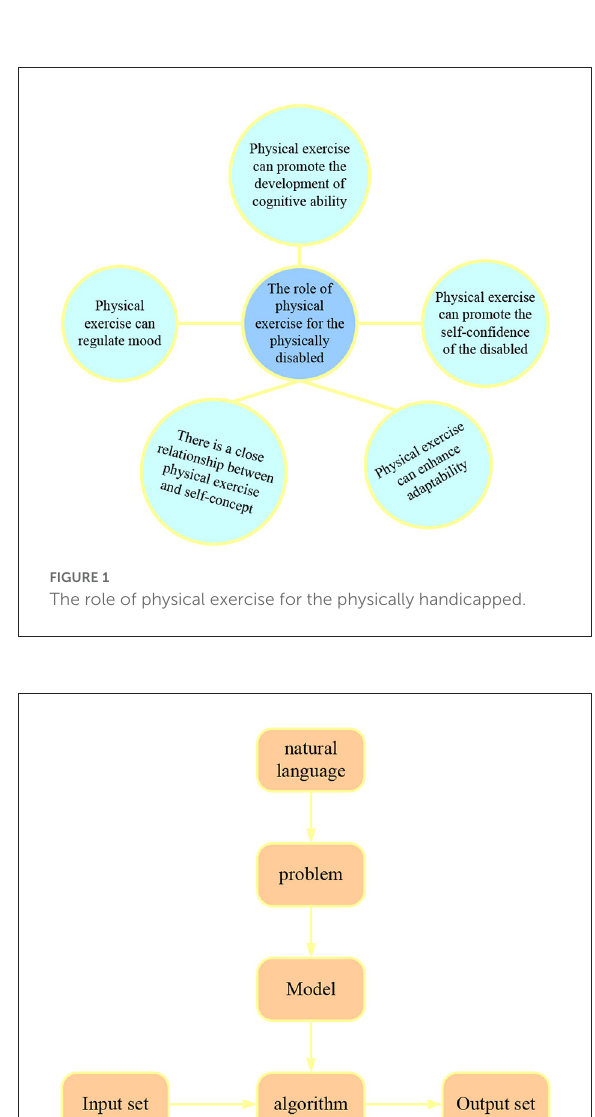
FIGURE2 Natural language processing